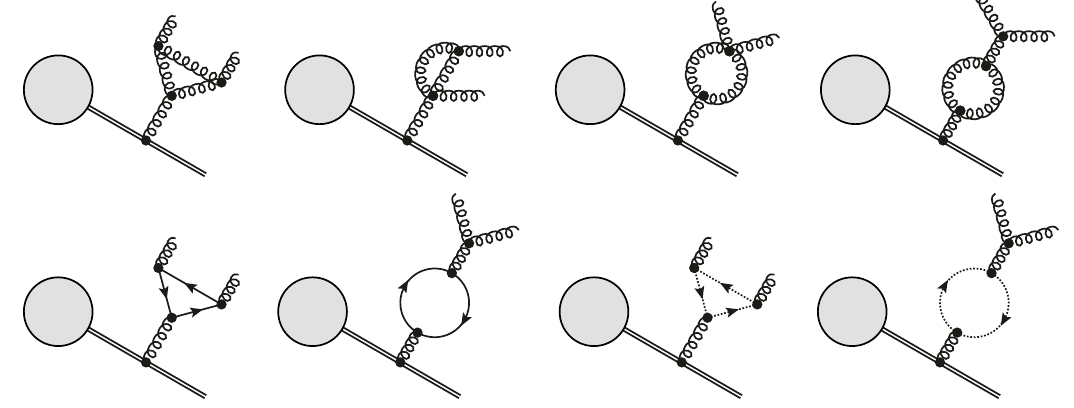
Figure 4 . Diagrams with a single off-shell gluon coupling to the Wilson line. Description of the diagrams as in figure 3. Notice the presence of a quark loop (denoted by a single line with arrow for fermion flow direction) as well as that of a ghost loop (denoted by a dotted line). Diagrams with ghosts are due to the use of the Feynman gauge.